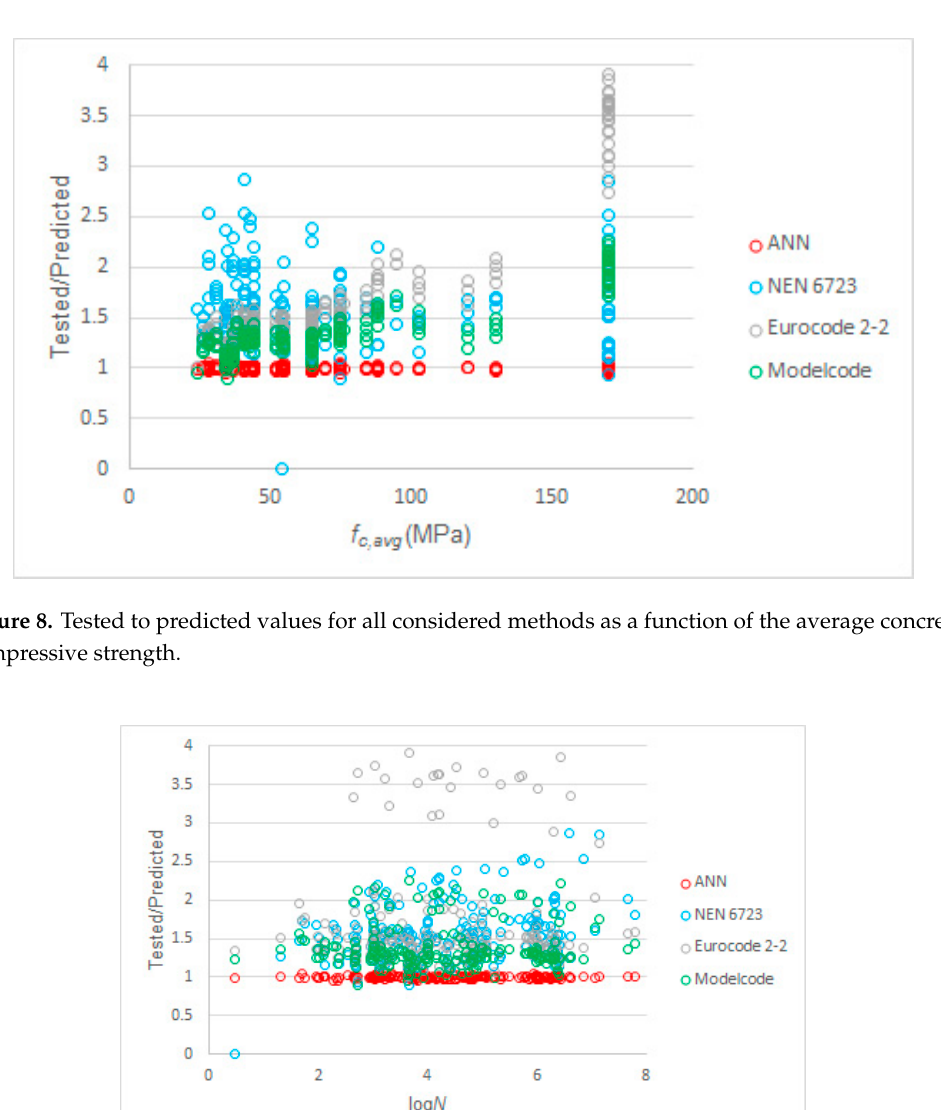
Figure 10. Tested to predicted values for all considered methods as a function of S max .